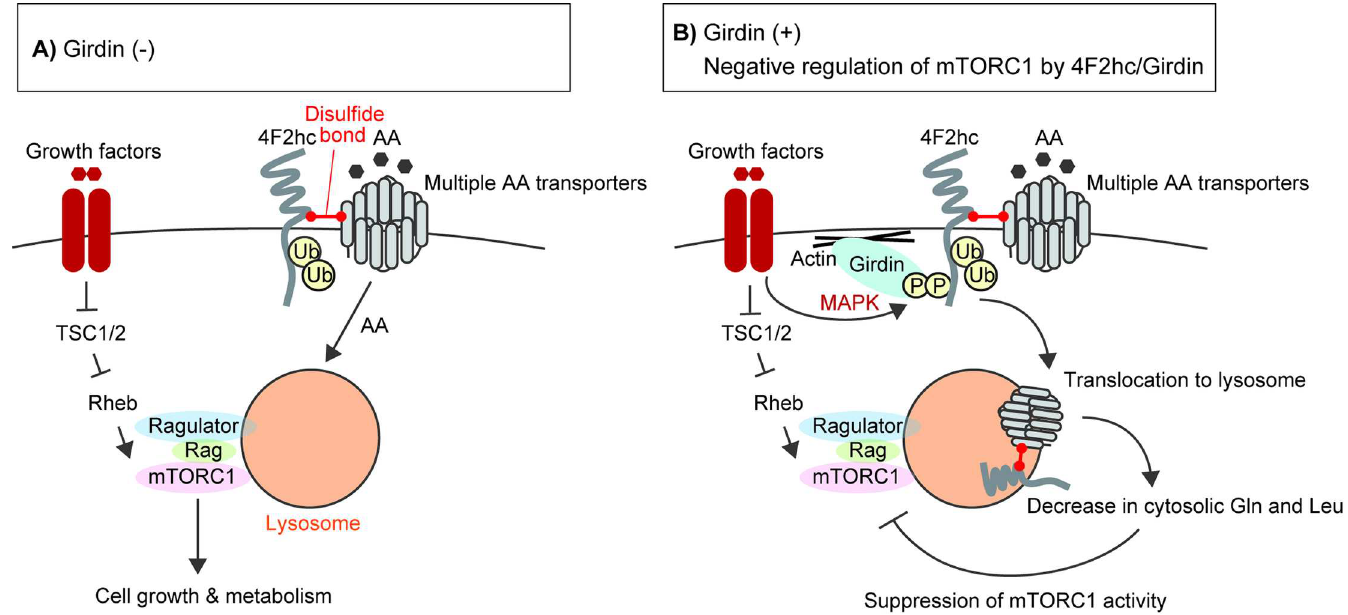
Fig 7. Schematic model of the negative regulation of amino acid signaling by the 4F2hc/Girdin complex. (A) In the absence of the 4F2hc/Girdin complex, various growth factor and amino acid signaling pathways converge on mTORC1 to regulate its activity and cell metabolism. (B) In the presence of Girdin, it interacts with 4F2hc depending on MAPK activity and amino acid stimulation, which promotes endocytosis of 4F2hc into the lysosome, leading to changes in intracellular Gln, Leu, and mTORC1 activity. AA, amino acids; Girdin, girders of actin filaments; Gln, glutamine; Leu, leucine; MAPK, mitogen-activated protein kinase; mTORC1, mechanistic target of rapamycin complex 1; TSC, tuberous sclerosis; Ub, ubiquitin; 4F2hc, 4F2 heavy